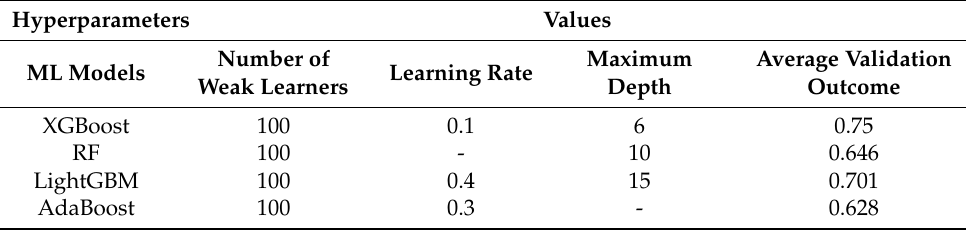
Table 2. Values of major hyperparameters of ML models used for resistance prediction.